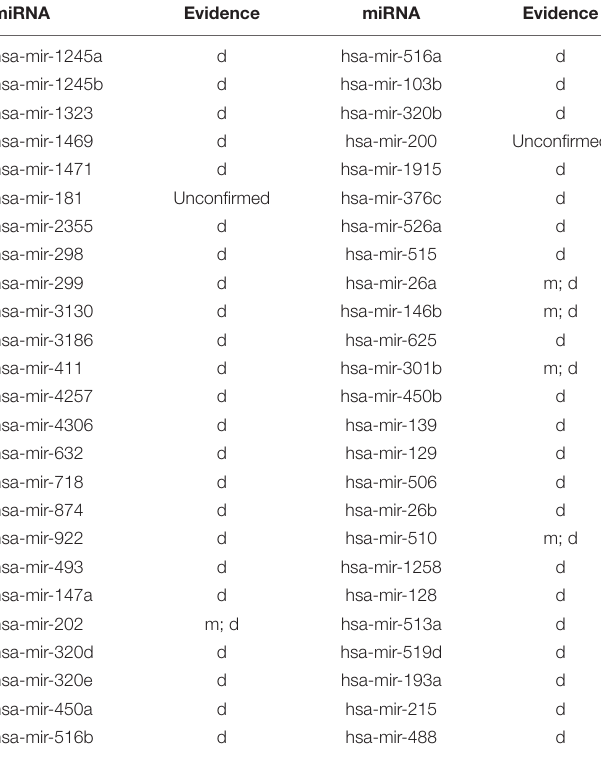
TABLE 3 | The top 50 potential miRNAs associated with prostate neoplasms. miRNA Evidence miRNA Evidence